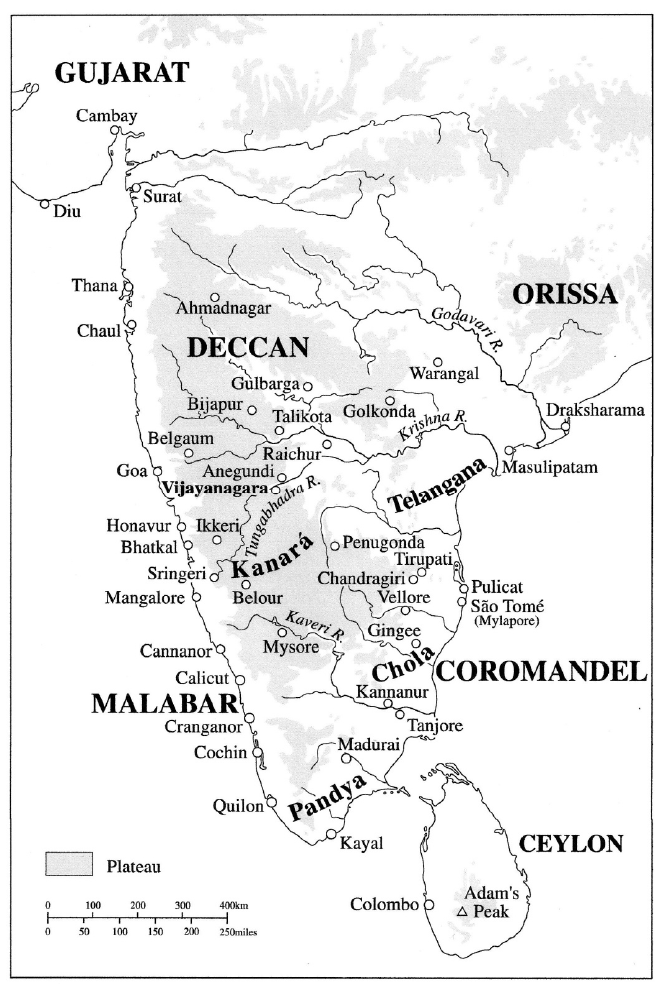
Figure 1. Map of south